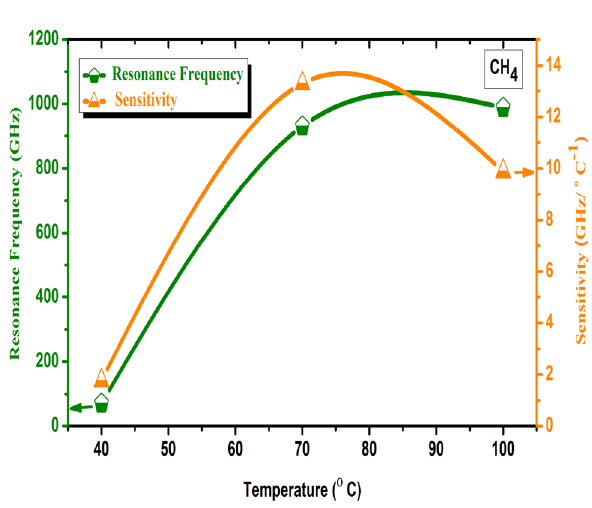
Figure 7. Effects of temperature on the resonance frequency and sensitivity of the FC(7, 1) quasi-periodic gas sensor towards CH 4 gas at 40, 70, and 100